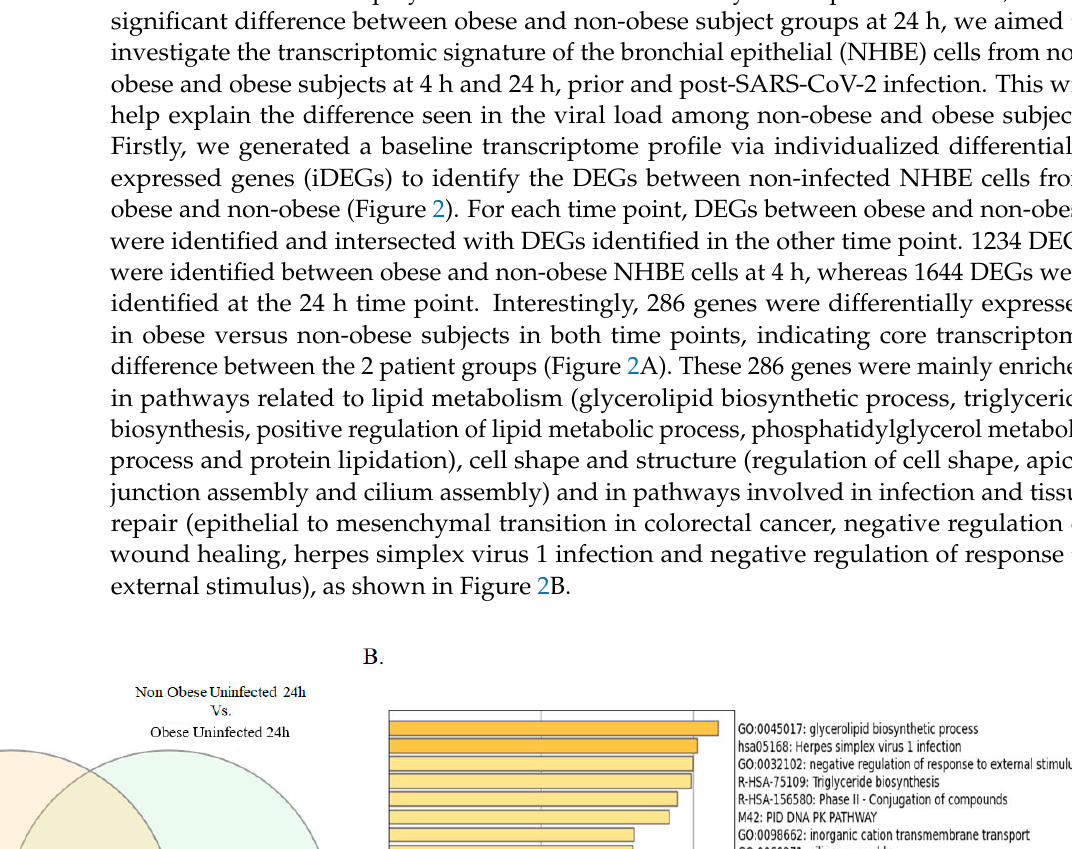
Figure 3. Core transcriptome of bronchial epithelial cells during SAR-CoV-2 infection. ( A ) Venn diagram of intersecting DEGs from non-infected, infected, bronchial epithelial cells from non-obese and obese at 4 and 24 h post-infection. ( B ) Enrichment analysis of the 41 genes found in the